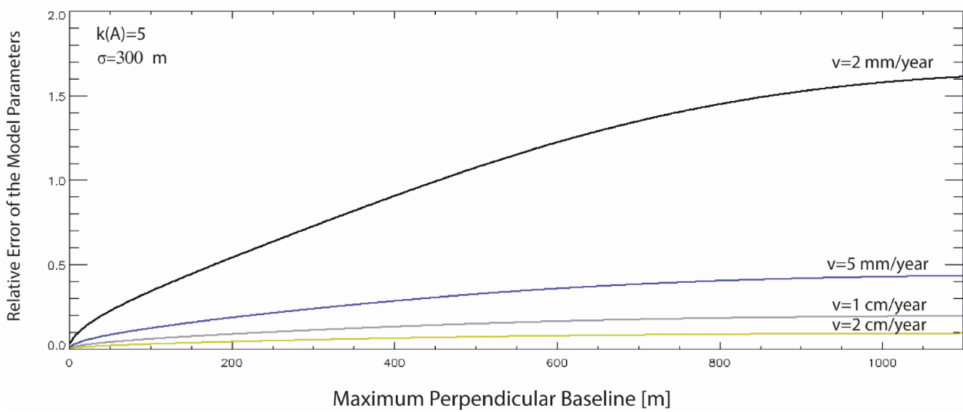
Figure 8. Upper bounds of the relative error of the measurement model parameters vs. the maximum perpendicular baseline of the SB interferogram, considering different mean ground displacement values of the observed SAR pixel on the